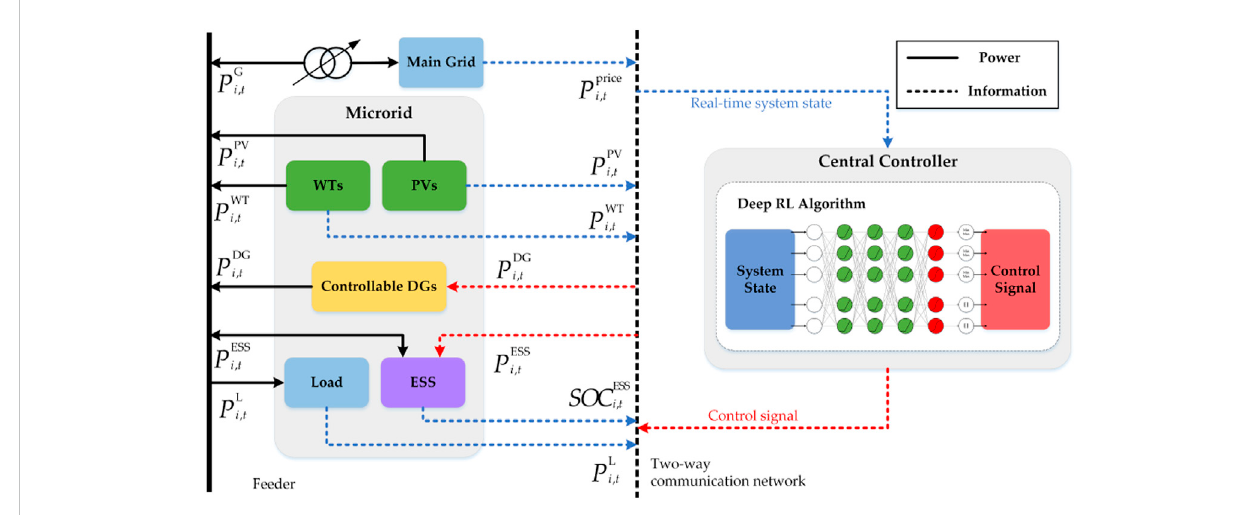
FIGURE 1 Real-time energy management framework of microgrids